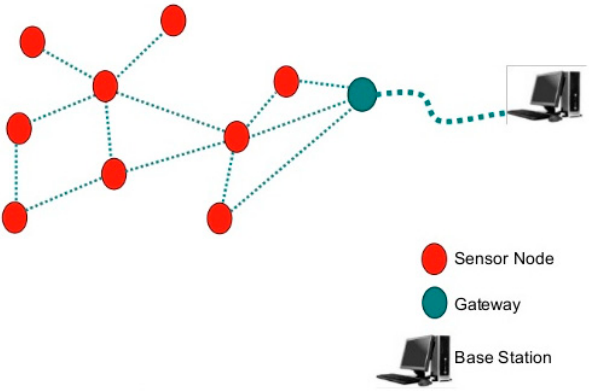
Figure 1. Wireless Sensor Network (WSN) Components, Gateway, and Distributed Nodes.